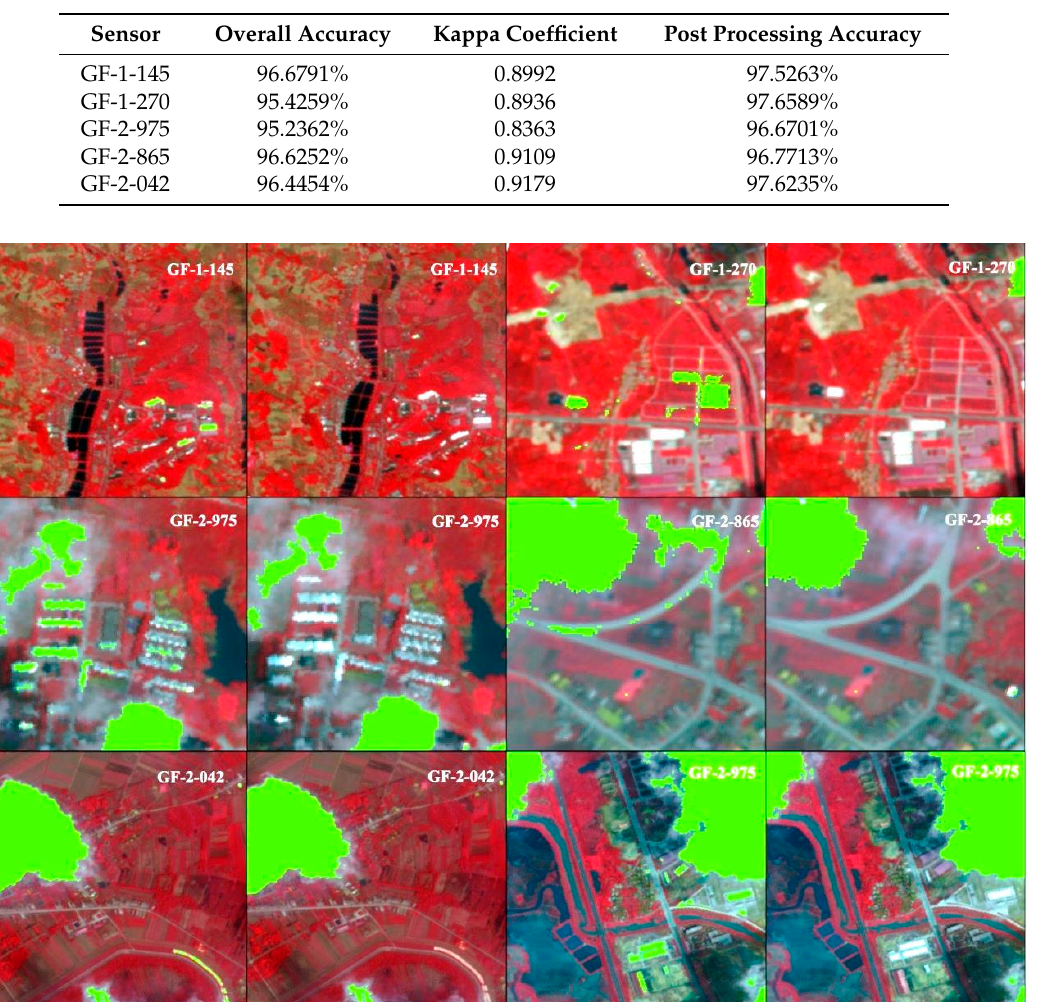
Table 4. Rough cloud detection accuracy and object-oriented post-processing accuracy for five GF-1/2 images.